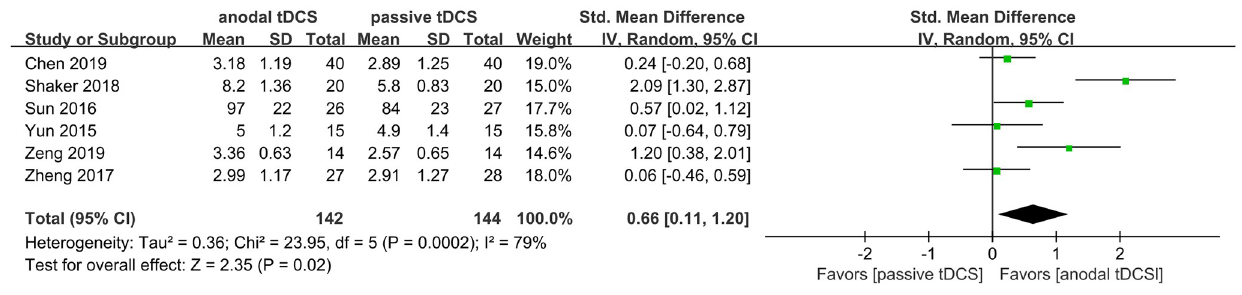
Fig 6. Forest plot of attention performance.